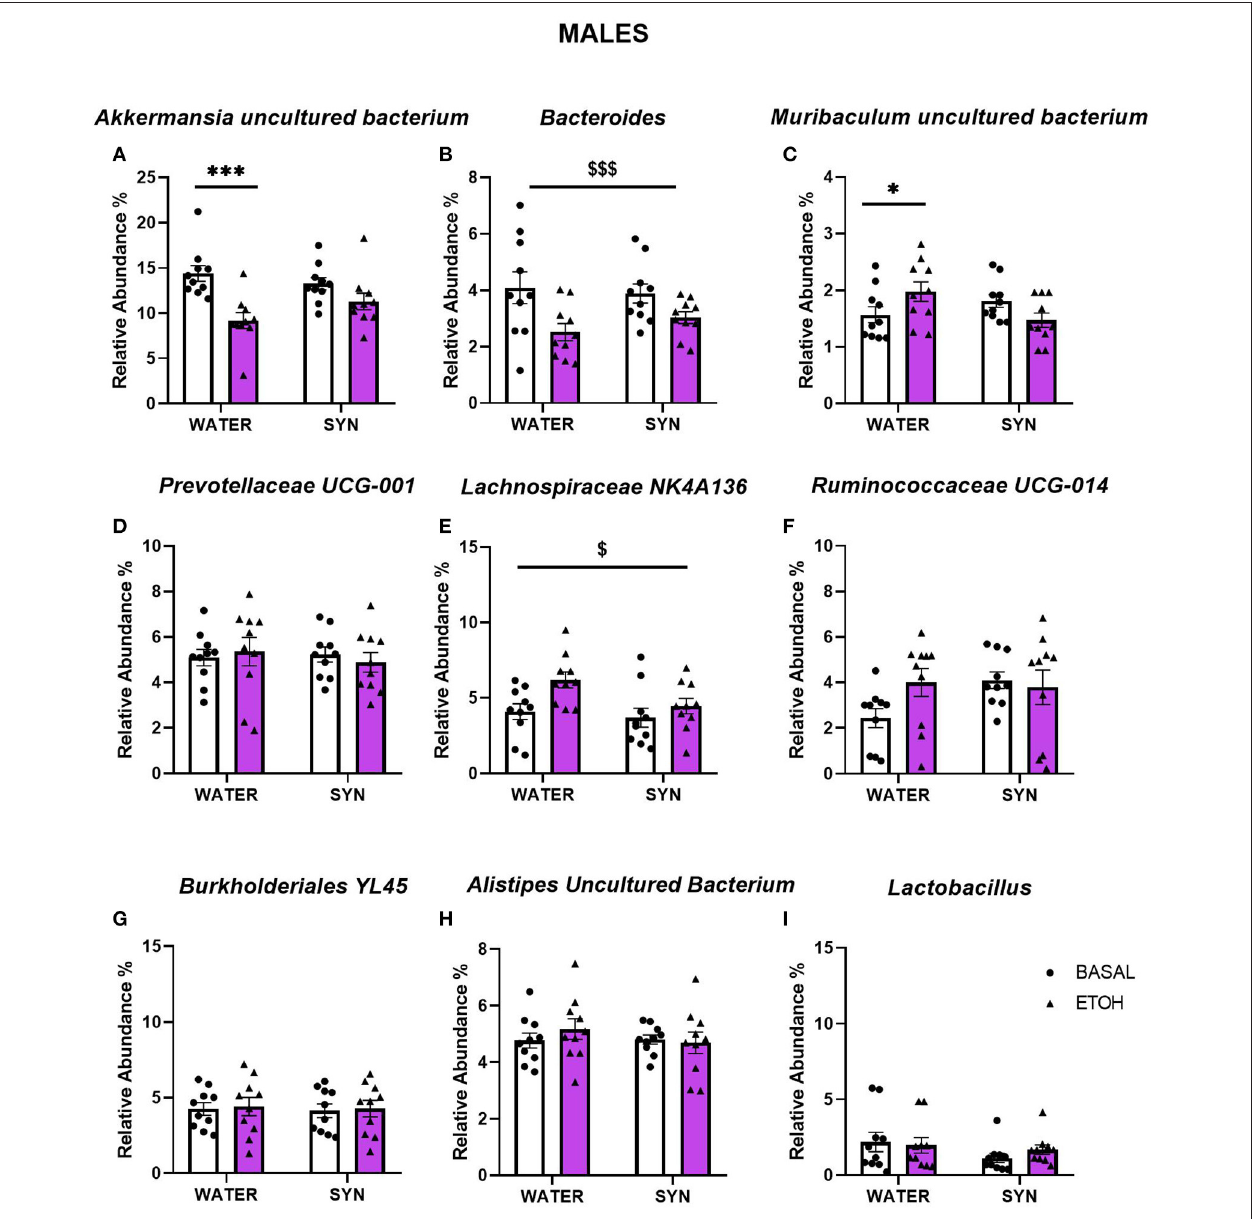
FIGURE 8 | Changes in gut microbial species relative abundance following intermittent alcohol intake in male mice treated with water or synbiotic (SYN) following 2 weeks of baseline (BASAL; no alcohol; white bars, round symbols), and after 20 days of intermittent access to alcohol (ETOH, violet bars, triangular symbols). The abundance of Akkermansia uncultured bacterium (A) was significantly decreased by alcohol only in the water group ( p < 0.001). For the Bacteroides (B) , alcohol-reduced its abundance in both the water and synbiotic groups. Alcohol significantly increased the abundance of Muribaculum uncultured bacterium (C) only in the water group ( p < 0.05). Alcohol increased the abundance of Lachnospiraceae NK4A136 (E) in both the water and the synbiotic groups. No significant changes were observed for Prevotellaceae UCG-001 (D) , Ruminococcaceae UCG-014 (F) , Burkholderiales bacterium YL45 (G) , Alistipes uncultured bacterium (H) ,